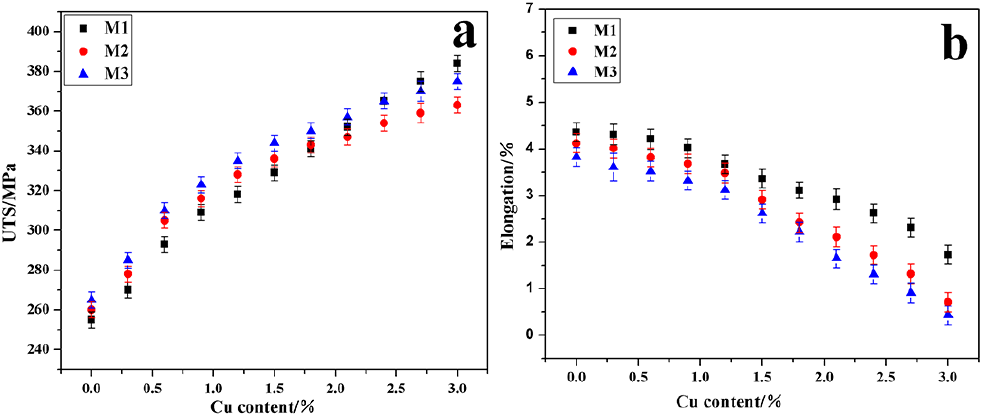
Figure3. EvolutionofmechanicalpropertiesofalloysM1, M2, andM3intheheattreatment. ( a )Ultimate Figure 3. Evolution of mechanical properties of alloys M1, M2, and M3 in the heat treatment. ( a ) tensile strength (UTS), ( b ) elongation to fracture (E%). Ultimate tensile strength (UTS), ( b ) elongation to fracture (E%).